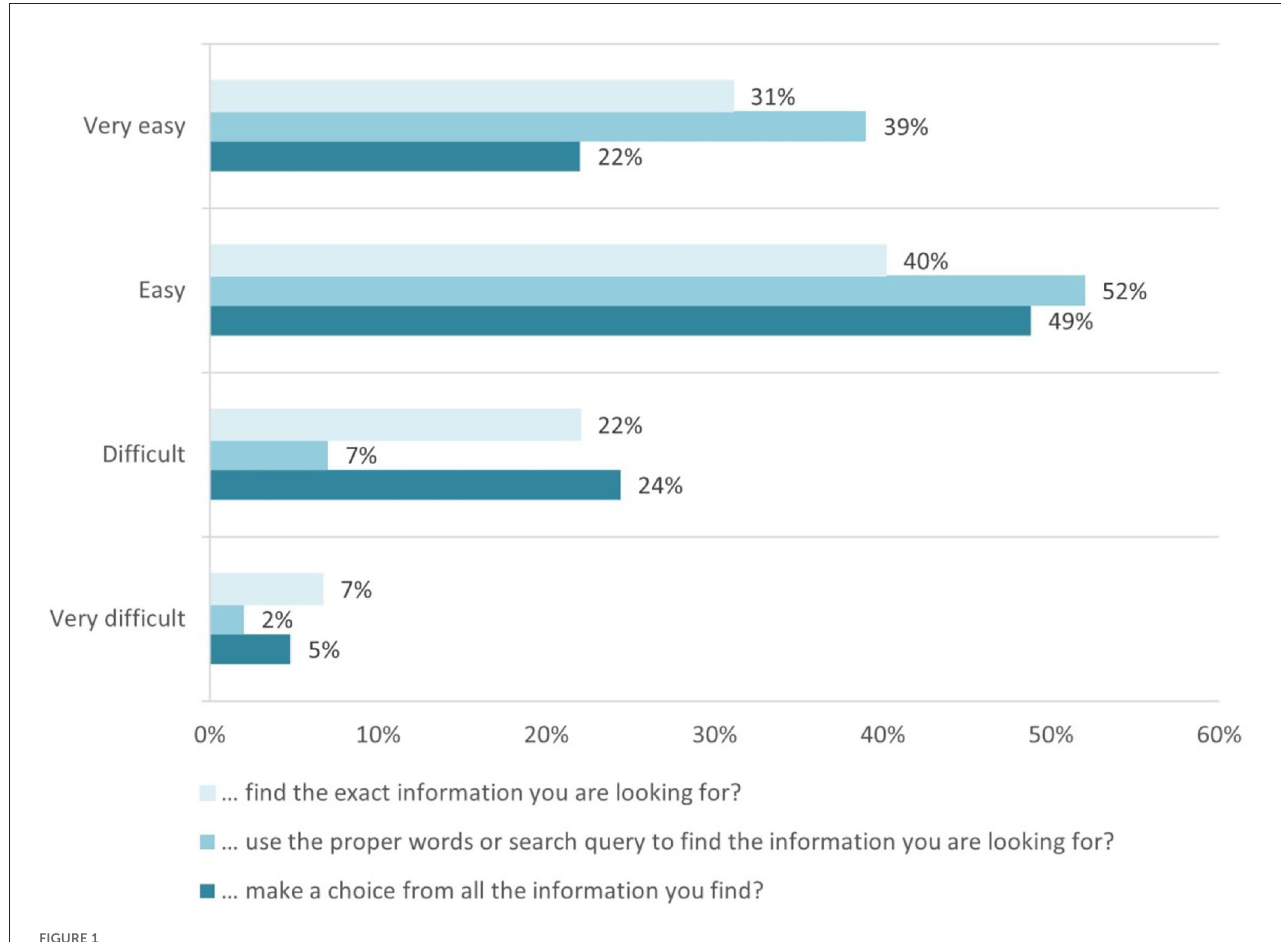
FIGURE1 Evaluation of students’ ability easily to find good health